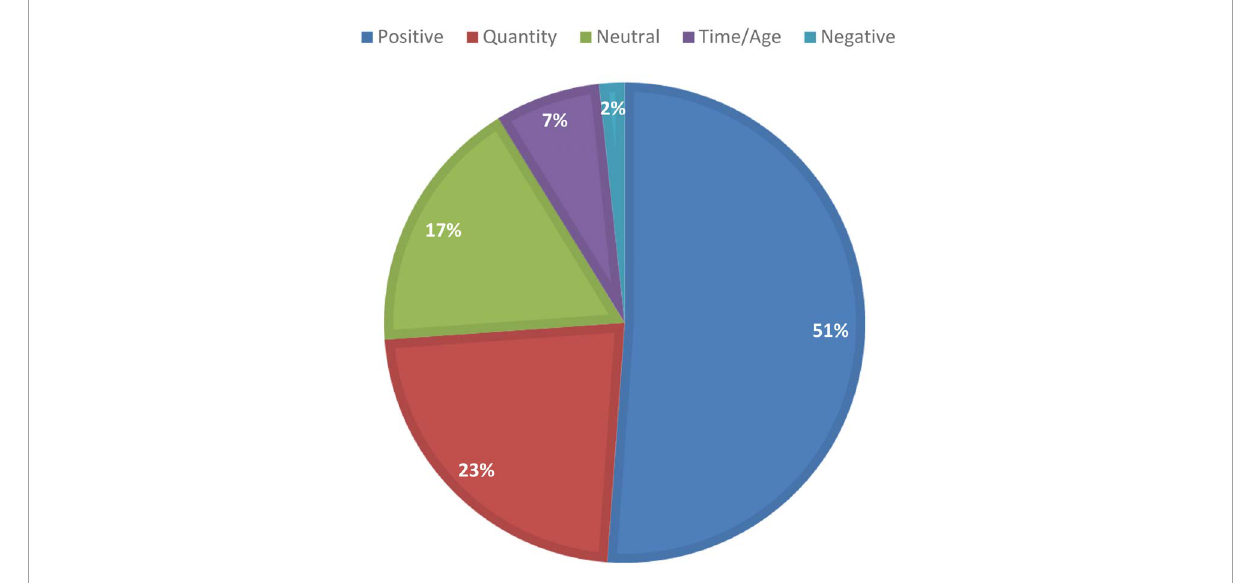
FIGURE4 Major semantic categories for the top 50 adjectives in the FoC.